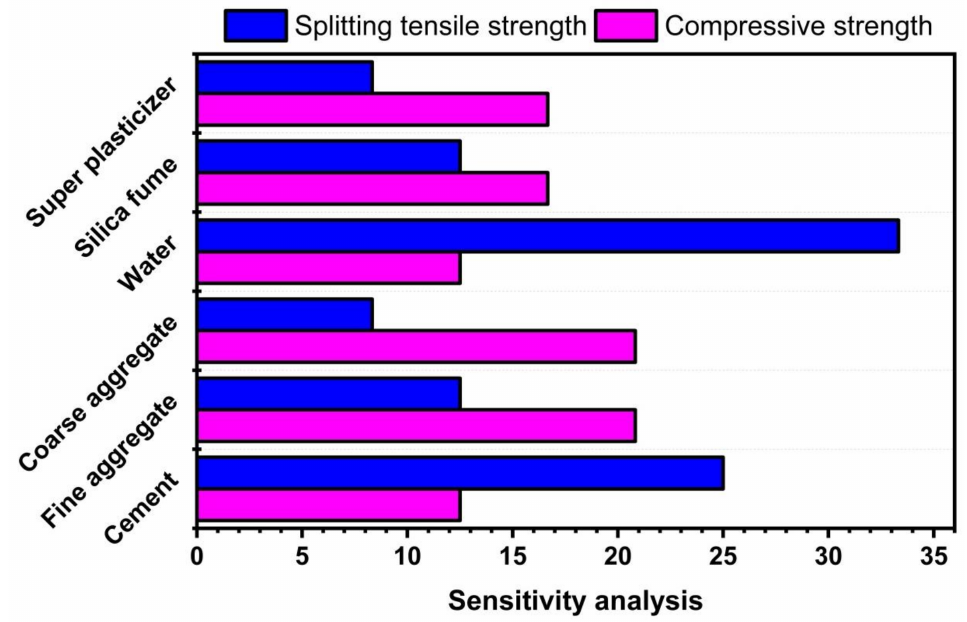
Figure 10. Contribution of input parameters to compressive and splitting tensile